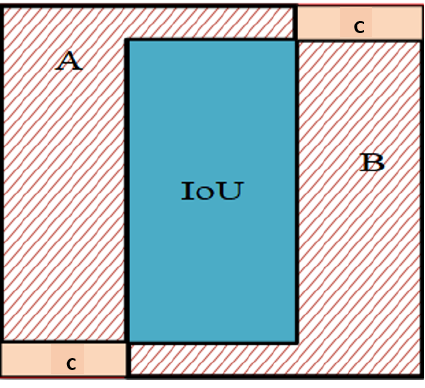
Figure 7. Diagram of IoU and C